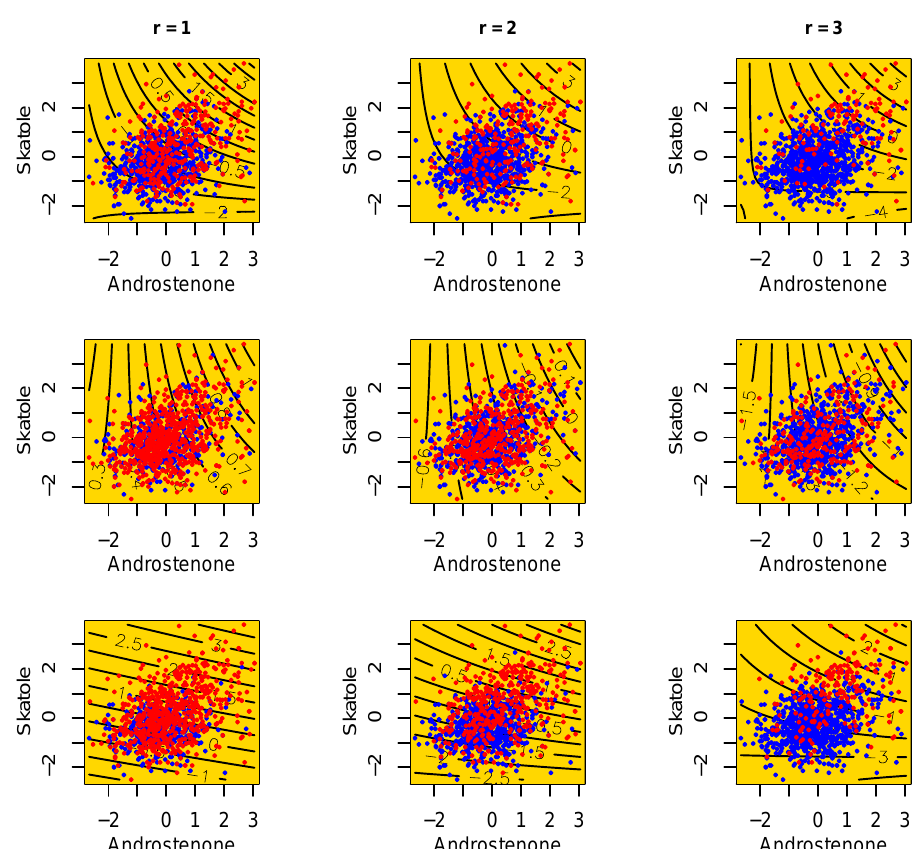
Figure 6. The result of the empirical application of SERP on the sensory data, showing the fitted log-odds of deviant smell ratings as a function of (log-transformed, standardized) androstenone and skatole for different cut-points r (the columns), and for panelists G, H and I (the rows). Data points observed (dots) are color-coded, where Y i > r (red dots) and Y i ≤ r (blue dots). Further comparison of SERP and the other methods were made with respect to the out-of-sample MSPE of the respective methods. Those were obtained for each of the panelists on a randomly chosen test set amounting to 20% of the original data set and over 100 replications of this experiment. Figure 7 captures the pairwise prediction error differences of SERP against (N)POM (with differences above zero favoring SERP). As observed, SERP shows distinct improvement over NPOM for 9 out of 10 panelists, as a greater amount of differences are seen over the dashed horizontal line for the respective panelists. Improvement over POM, however, is much less pronounced than SERP’s im- provement over NPOM. For panelists A, D, E, and G, at least the median of differences is (slightly) above zero. For the other panelists, though, SERP is still not worse than POM. In summary, SERP appears to be a safe choice when it comes to modeling/prediction of panelists’ ratings in our application. Compared to standard approaches (POM and NPOM), results in terms of prediction accuracy are at least similar, but often better. With respect to boar taint perception, our results impressively show that people can be very different, both in terms of the effects of androstenone and skatole, as well as (non-)proportionality. This needs to be kept in mind, for instance, when hiring raters for detecting boar-tainted carcasses at the slaughter